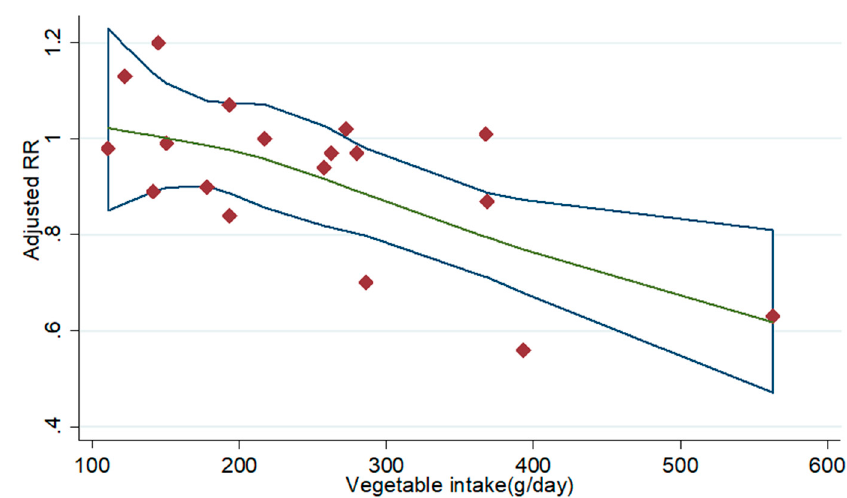
Figure 6. Dose-response analysis for the curvilinear association between intakes of vegetable in current smokers and lung cancer risk. Abbreviations: RR—relative risk.